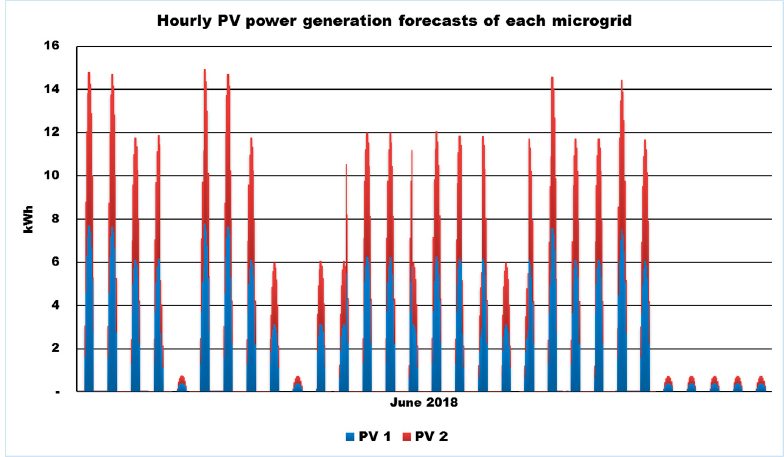
Figure 5. Hourly photovoltaic power generation forecasts of each microgrid.